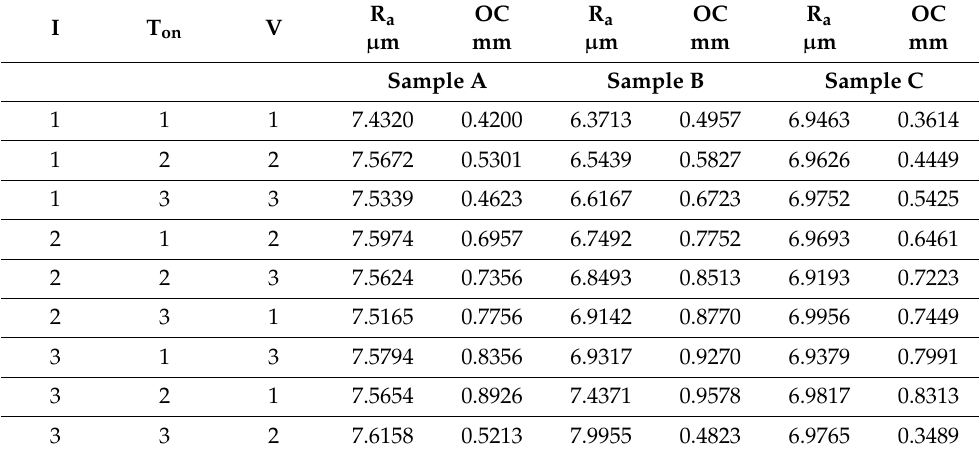
Table 2. Experimental results for samples A, B, and